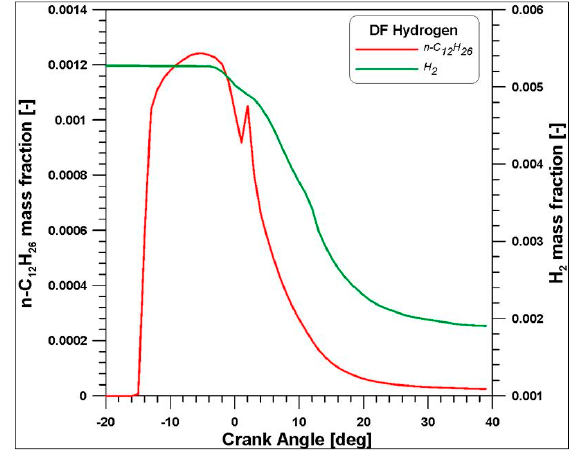
Figure 15. Numerical H 2 and n-C 12 H 26 mass fraction.